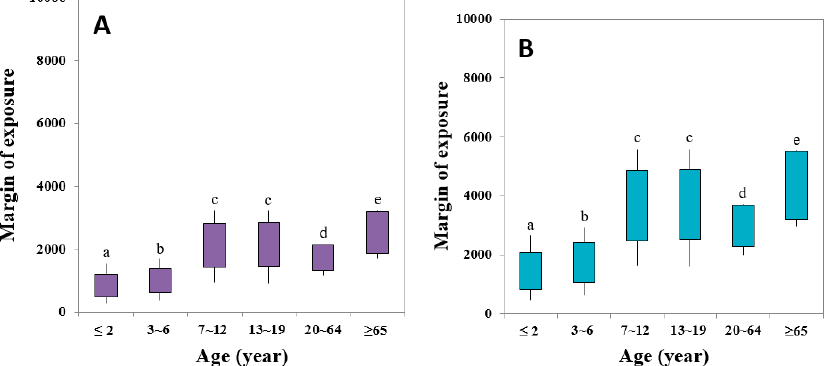
Figure 1. Margin of exposure (MOE) of age classes with acrylamide intake compared to benchmark dose lower confidence limit (BMDL 10 ) (( A ) Harderian gland tumors in mice and ( B ) mammary tumors in rats). Upper end of the line: 50th percentile value, lower end of the line: 99th percentile values, upper end of the box: mean value, and lower end of the line: 95th percentile values. Statistical analysis was performed using one-way ANOVA test and Tukey’s post hoc test using SPSS 20 (SPSS Inc., Chicago, IL, USA). Alphabet (a–e) in the Figure indicates that the 50th percentile values of MOE with a same letter are not significantly different ( p < 0.01).